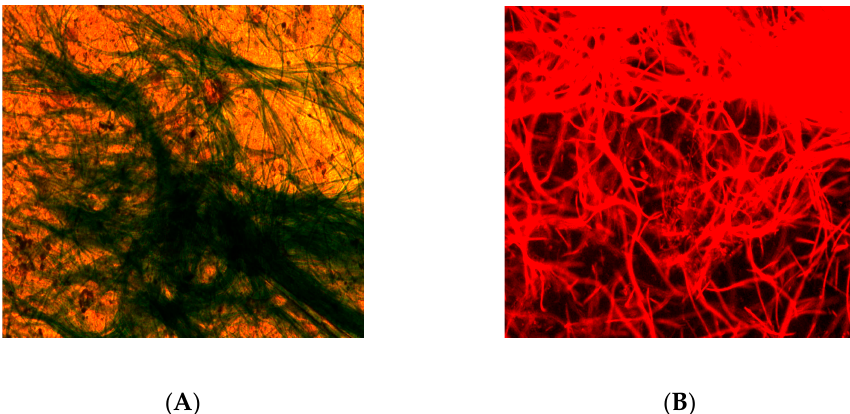
Figure 3. OPGs under microscope: ( A ) 10 × magnification, ( B ) fluorescent light image, 10 × magnifi- cation (own study).